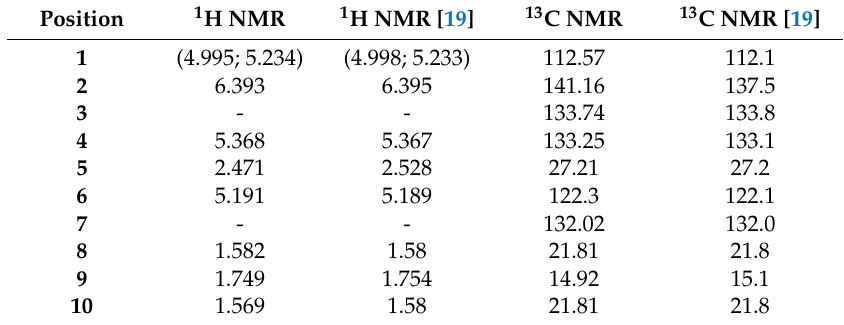
Table 4. NMR data of the substance (Z)- β -ocimene (S 5) compared to data in the literature.